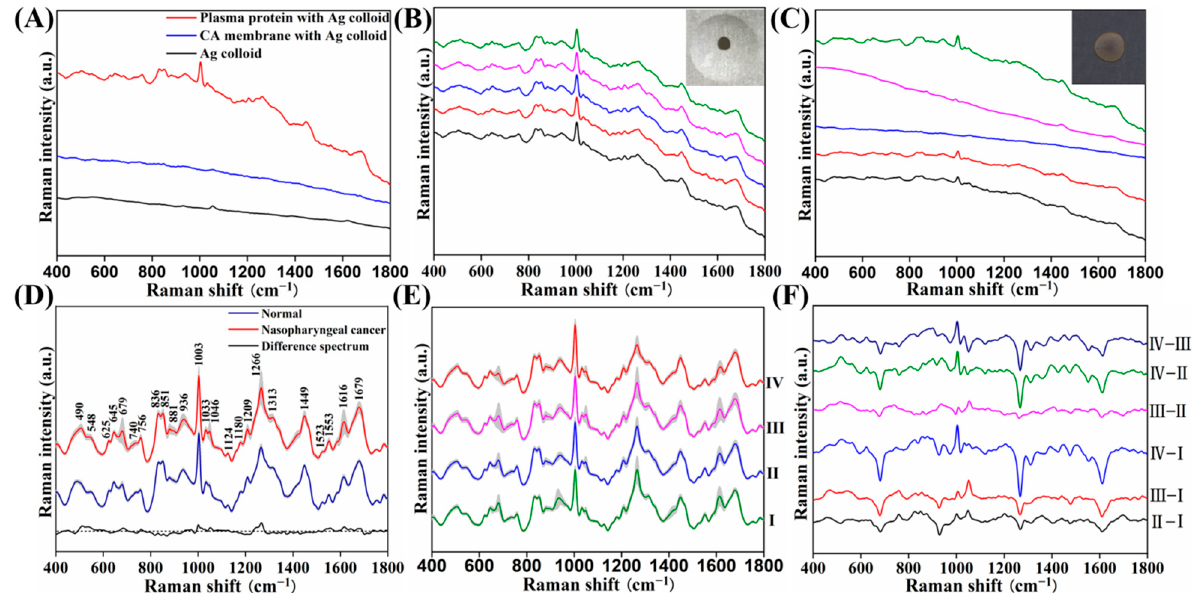
Figure 3. ( A ) Comparison of a SERS spectrum from plasma protein purified by CA membrane, a SERS signal from a blank CA membrane, and the background signal from the Ag NPs. ( B , C ) Spectra from five random sampling points along the diameters of the dried mixtures on the super-hydrophobic and the ordinary Al surfaces, respectively. ( D ) Comparison of the normalized average protein SERS spectra from healthy and all NPC subjects, and the corresponding difference spectrum (NPC minus normal). ( E ) Average protein SERS spectra from NPC subjects from the four stages, and ( F ) their corresponding difference spectra.